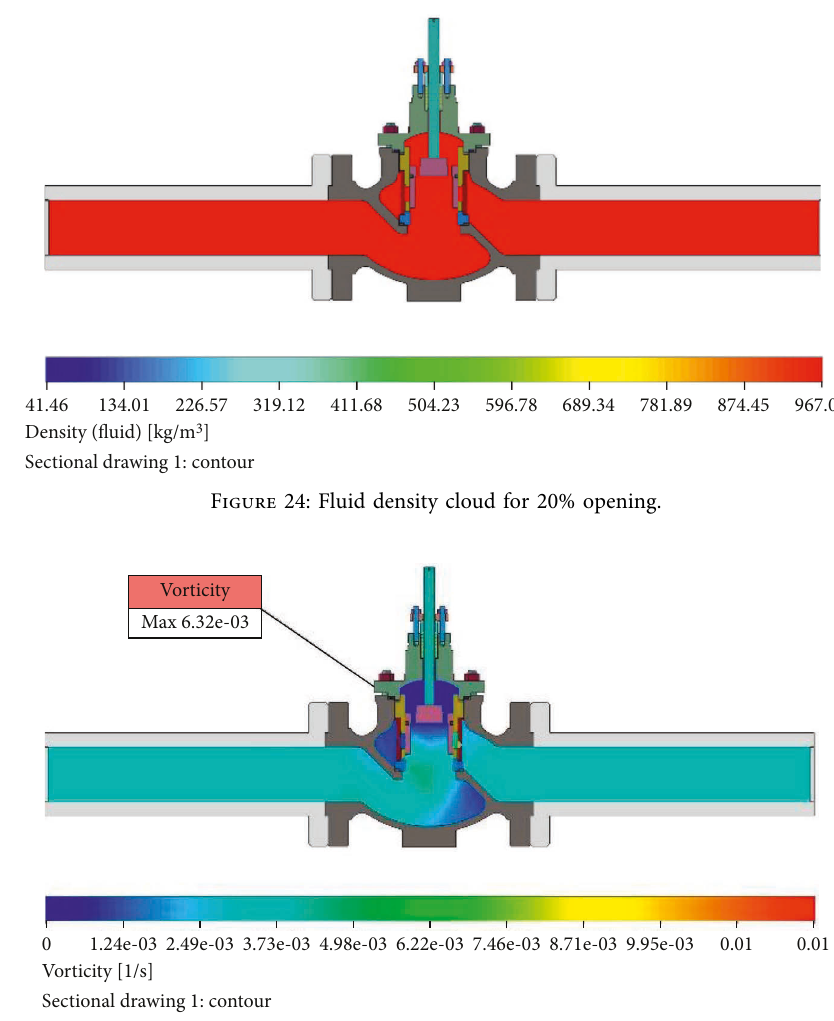
Figure 25: Mach number cloud map for 20% opening.